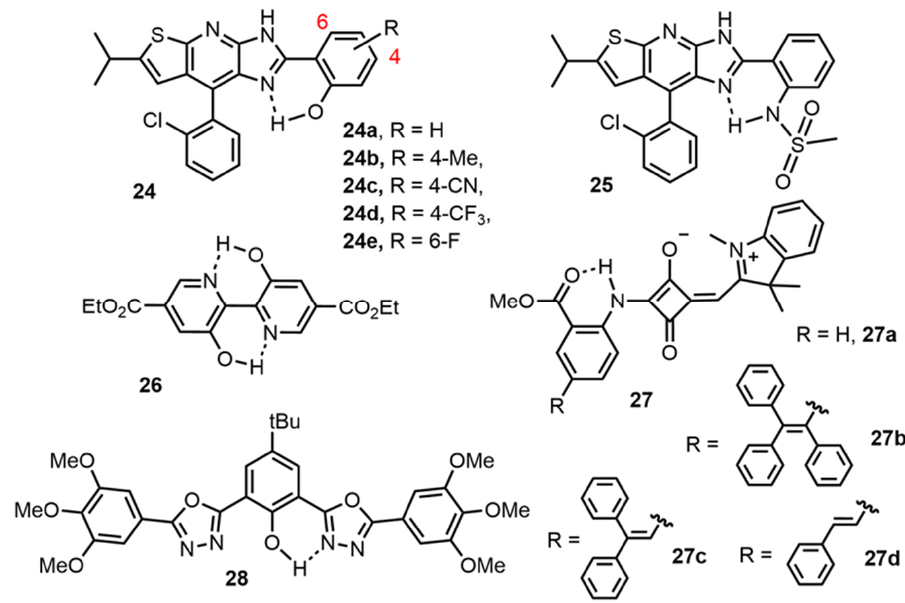
Figure 8. Examples of DSE/ESIPT fluorophores based on miscellaneous scaffolds [83 −